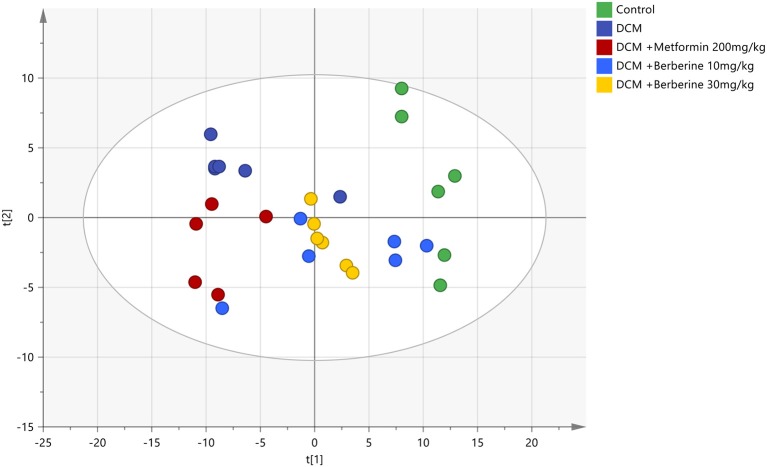
The PCA scores plot of five groups. DCM, diabetic cardiomyopathy. The colors display the subjects from different groups. , Control; , DCM; , DCM + Metformin 200 mg/kg; , DCM + Berberine 10 mmg/kg; , DCM + Berberine 30 mg/kg.